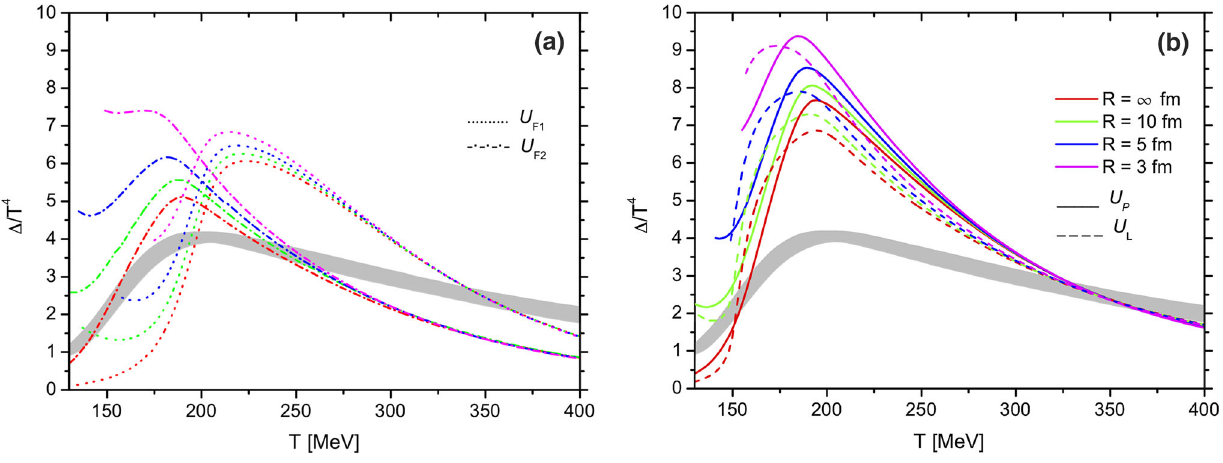
Fig. 4 We show Δ/ T 4 as a function of temperature for different drop sizes and different Polyakov loop potentials. We also include lattice QCD simulations data from [48] (gray